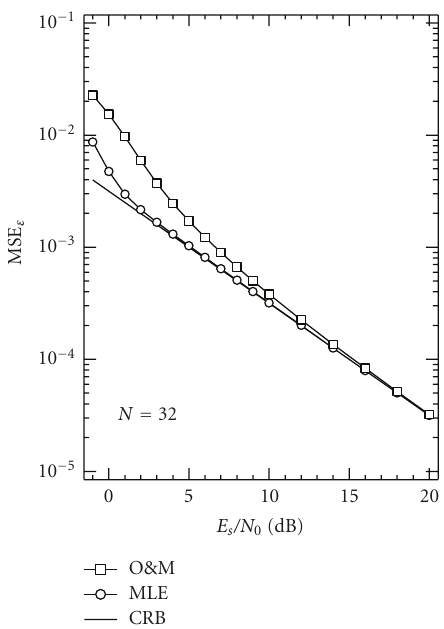
Figure 6: MSE performance of MLE and O&M estimator with N = 32.